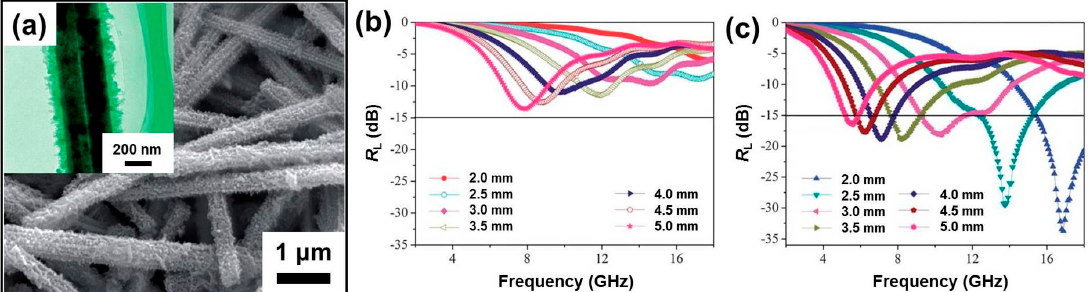
Figure 9. ( a ) SEM image of the branched PANI/ α -MoO 3 nanostructures. The inset shows a TEM image of the branched PANI/ α -MoO 3 ; The R L values of ( b ) the PANI nanorods and ( c ) the branched PANI/ α -MoO 3 nanostructures. Reprinted with permission from Reference [122].